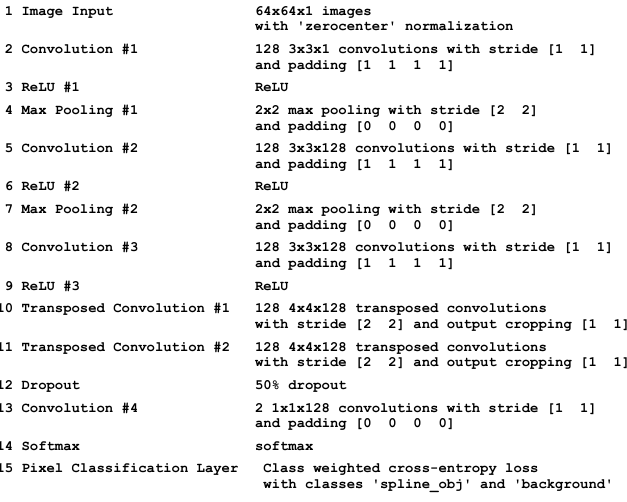
Fig. 5. The SSN architecture (in M ATLAB ) with three ConvLs and two DeConvLs. The DropOut layer following the last DeConvL is optional. The SSN is trained on the dataset whose regions have